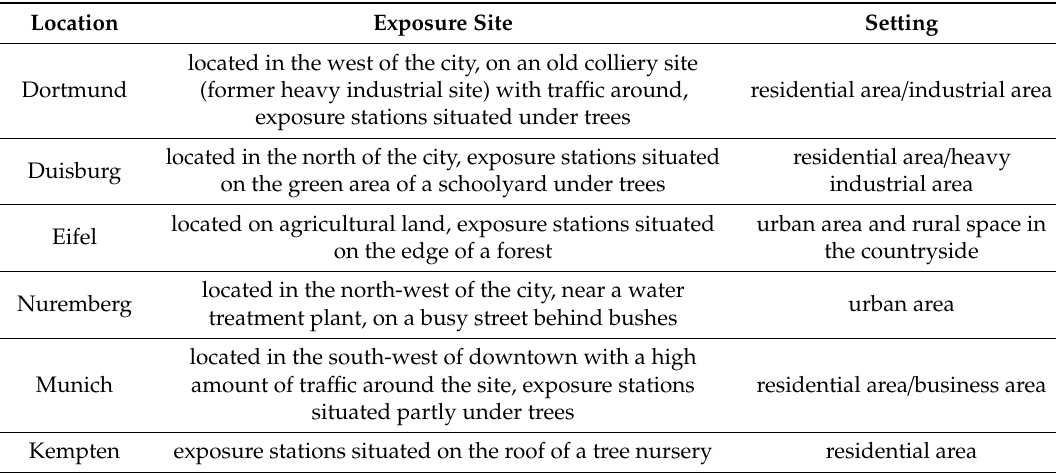
Table 3. Description of the exposure sites and their setting.